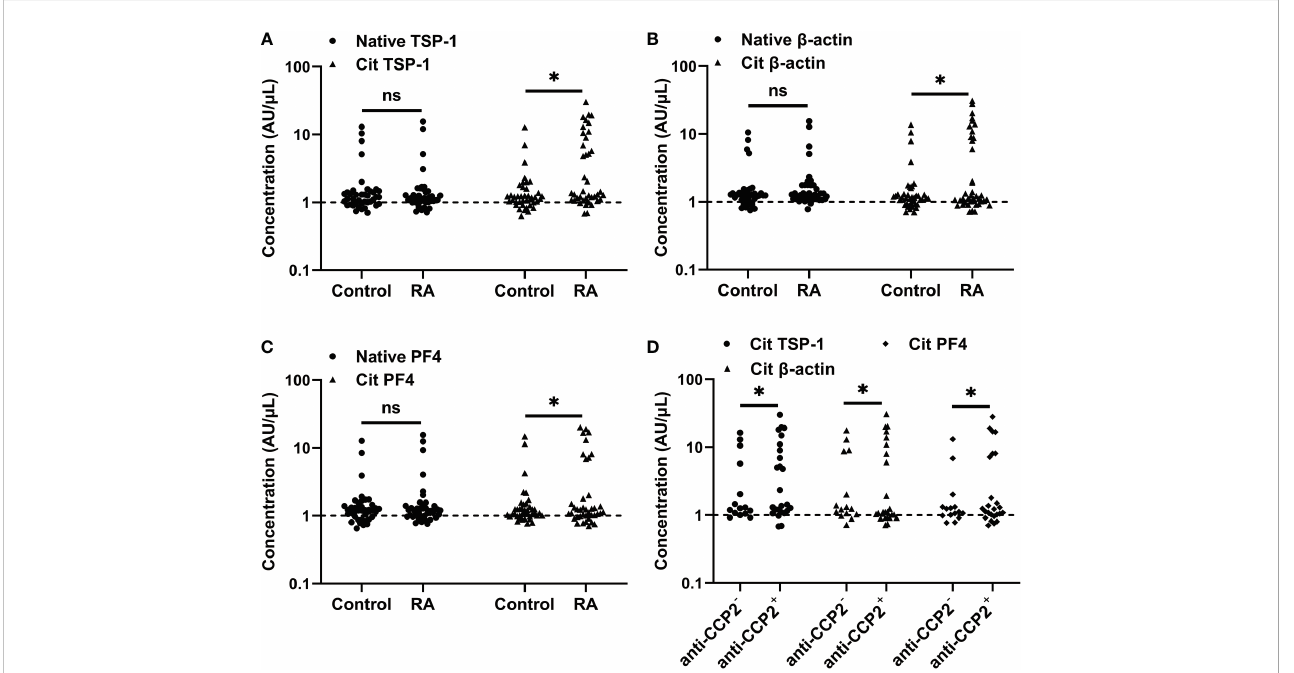
FIGURE 3 Measurement of citrullinated TSP-1, b -actin, and PF4 - speci fi c antibodies in the RA sera. (A-C) Determination of citrullinated TSP-1, b -actin, and PF4- speci fi c antibodies in the sera (1:100 dilution) of healthy controls and RA patients. (D) Distribution of citrullinated TSP-1, b -actin, and PF4-speci fi c antibodies in the anti-CCP2 + and anti-CCP2 - RA sera. Broken lines indicate the cutoff values. Cit, denotes citrullination, *p < 0.05, ns = not signi fi cant.